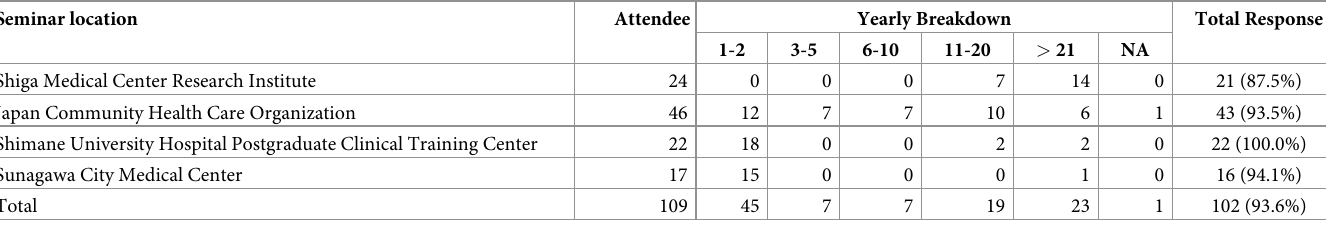
Table 1. Summary of responses for each survey setting. Seminar